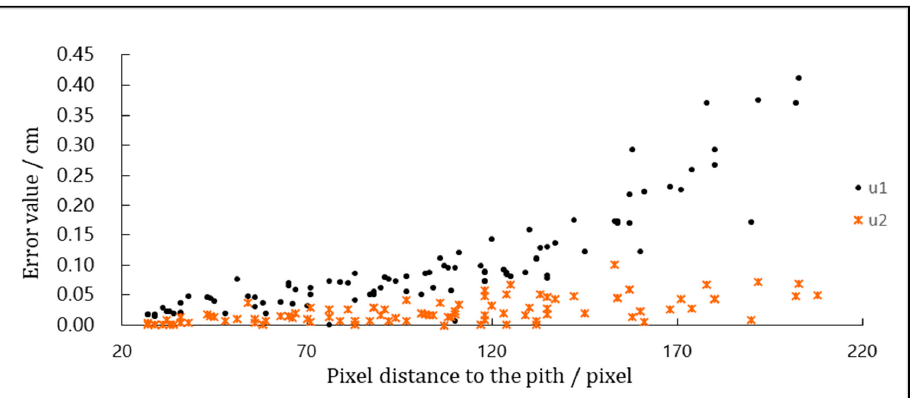
Figure 10. Comparison of the error values of the measured results based on exponential tree ring radius regression equation and polynomial regression equations after eliminating heteroscedasticity. The “u1” indicates that the error value of the tree-ring radius regression equation (Equation (11)) fitted by the exponential correction model, and “u2” indicates the error value of the tree-ring radius regression equation (Equation (12)) fitted by the polynomial correction model.